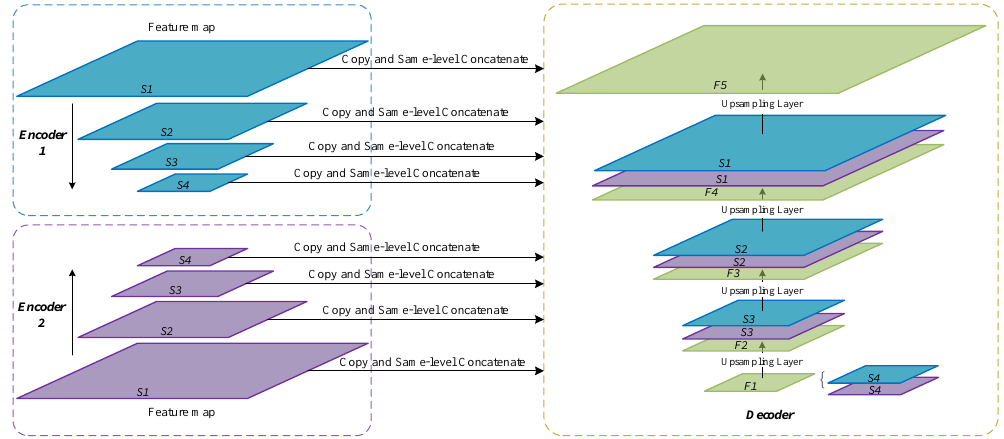
Figure 6. Structure of multi-scale decoder connected with encoder same-level features.